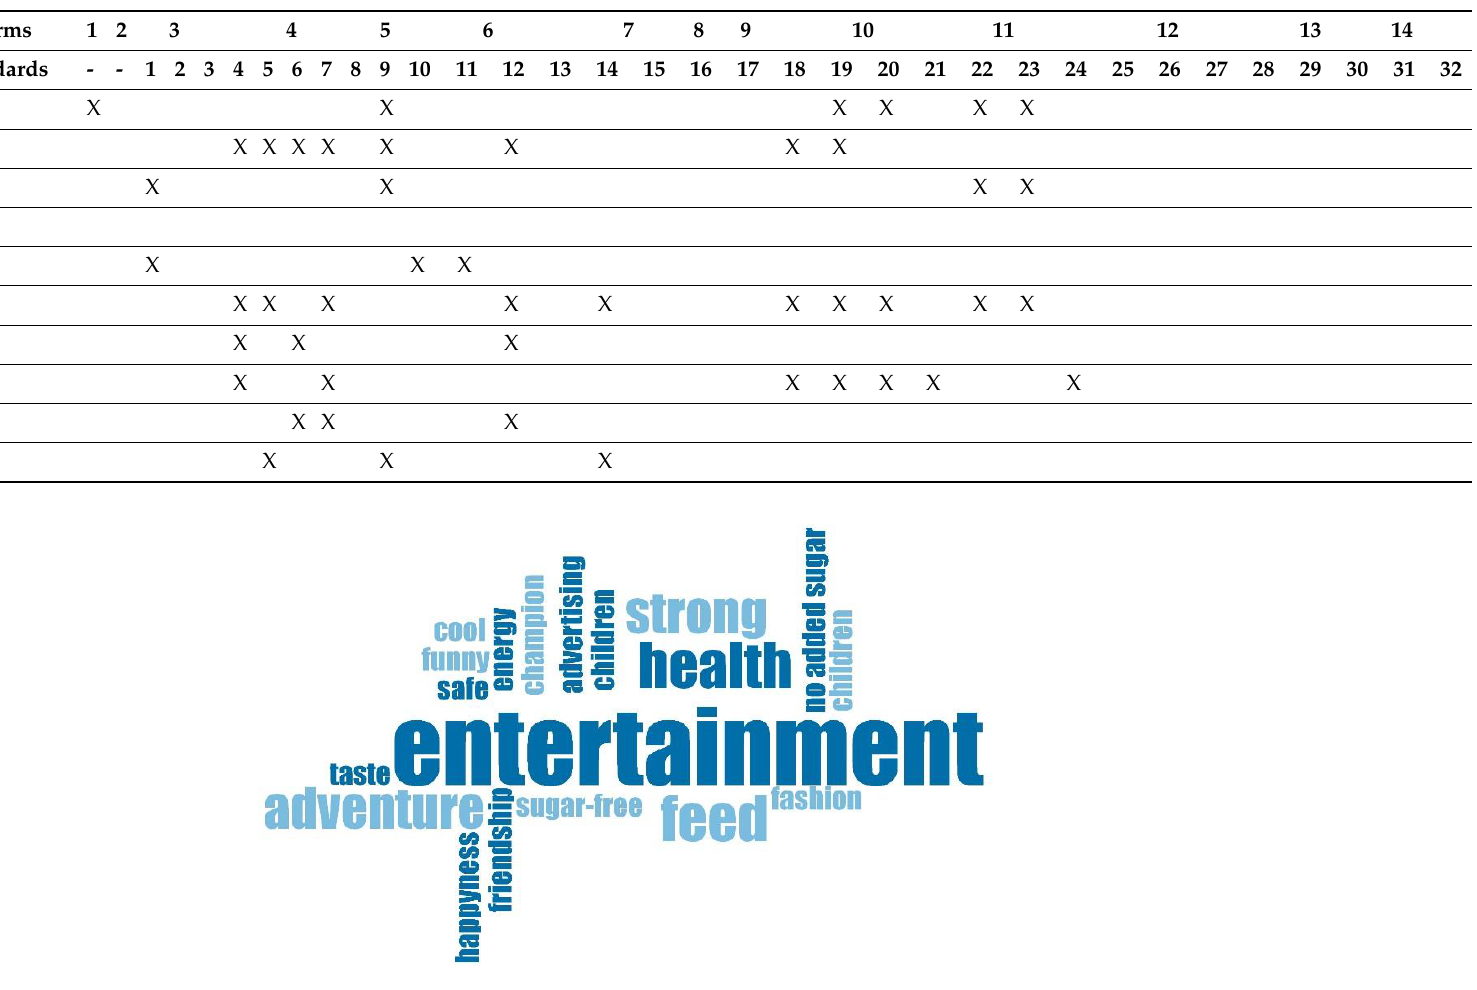
Figure 2. Words combinations found in the ads.